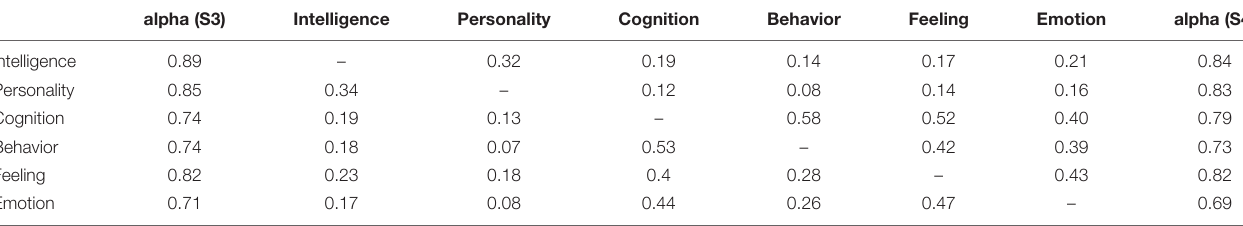
TABLE 8 | Correlation between implicit theories subscales in Study 3 and Study